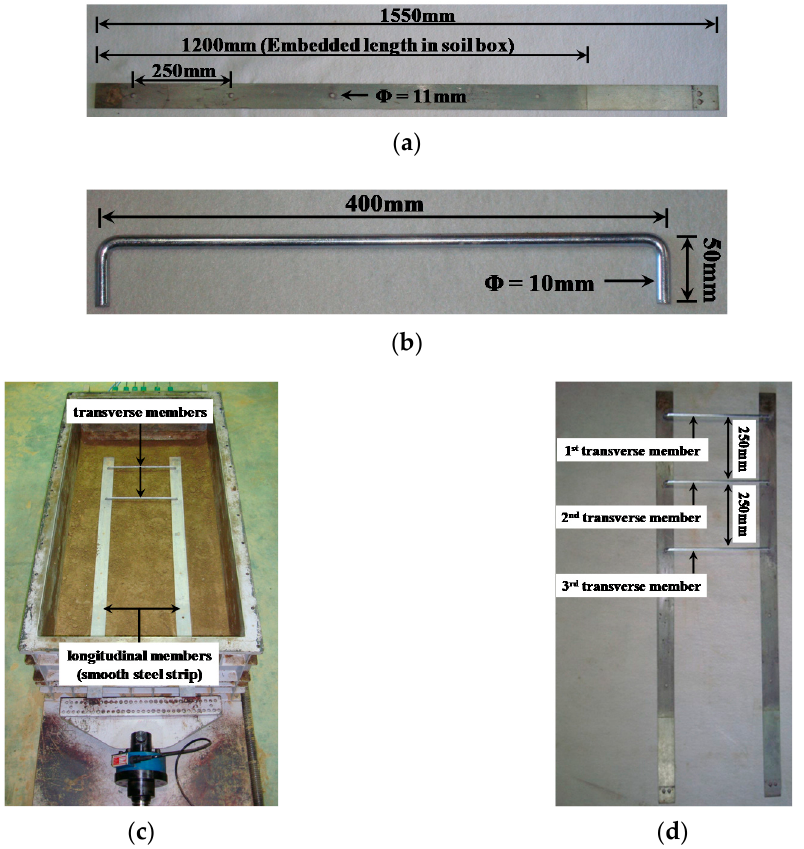
Figure 2. Reinforcements used in this study: ( a ) longitudinal member, ( b ) transverse member, ( c ) reinforcement installed in test box, and ( d ) installation location of transverse members.